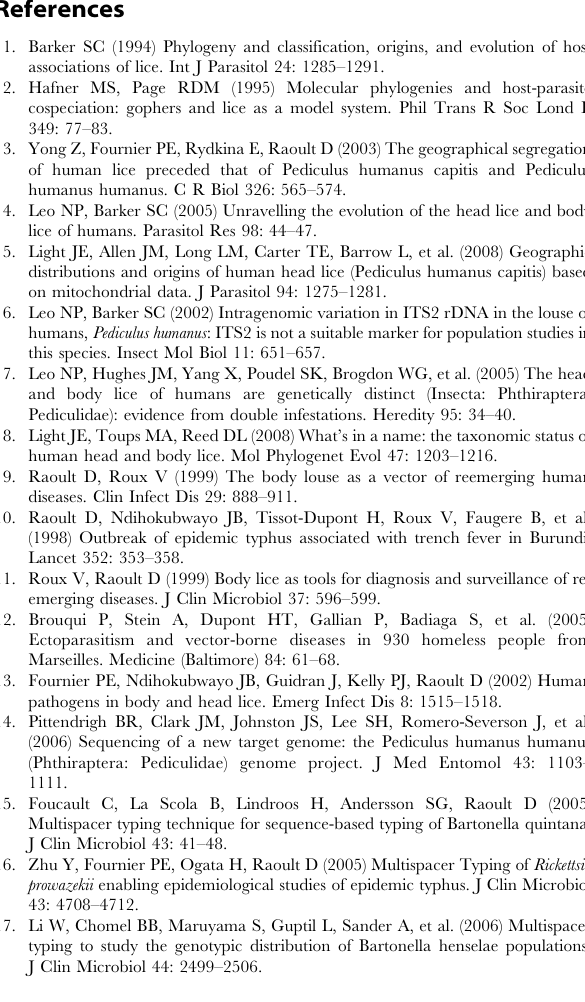
Figure S4 Phylogenetic organization of 174 human lice based on concatenation of two nuclear intergenic spacers, using the Maximum parsimony method. Figure S5 Phylogenetic organization of 97 human lice based on concatenation of four nuclear intergenic spacers, PM1, PM2, S2, and S5, using the Maximum parsimony method. Figure S6 Phylogenetic organization of 170 human lice based on partial sequence of the cytB gene, using the Maximum parsimony method. Found at: doi:10.1371/journal.pntd.0000641.s006 (0.02 MB